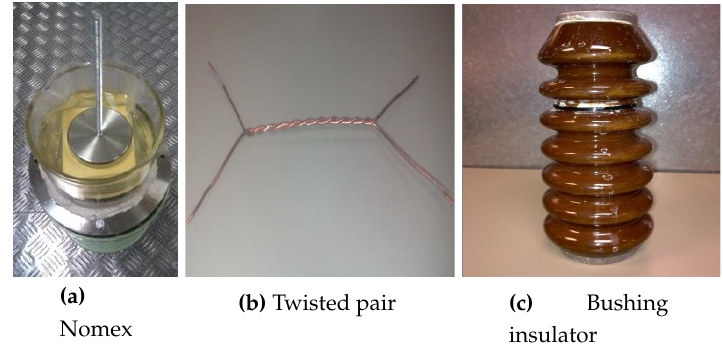
Figure 5. Test objects: ( a ) Nomex 4-3-4 submerged in oil, ( b ) twisted pair of copper wire type Pulse Shield SD, 23.5 × 12 cm with a central twist of 13.5 cm and ( c ) bushing insulator with an electrode in the top, 21 × 8